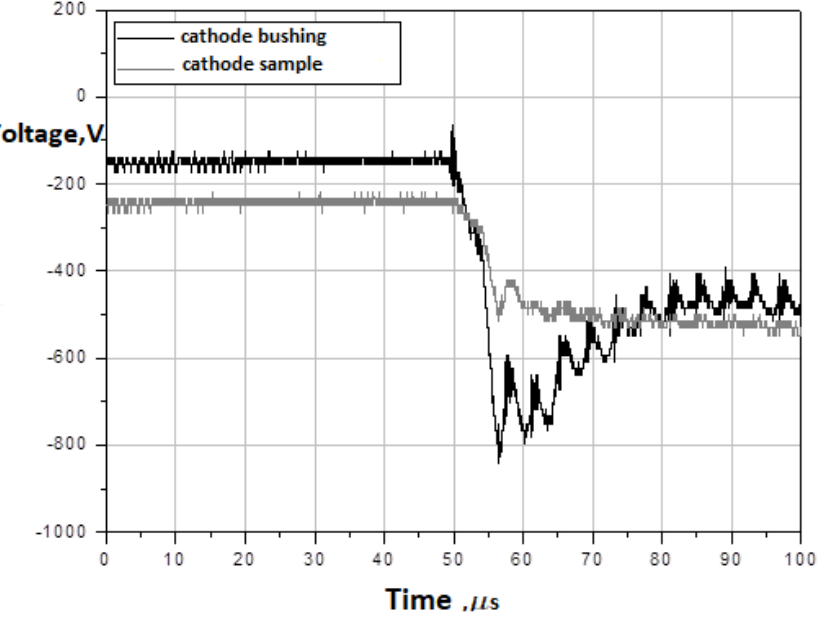
Figure 10. Comparison of the potentials at the cathode bushing (top) and on the surface of the control sample with galvanic contact with the cathode (bottom)—an elementary graduation of 10 µ